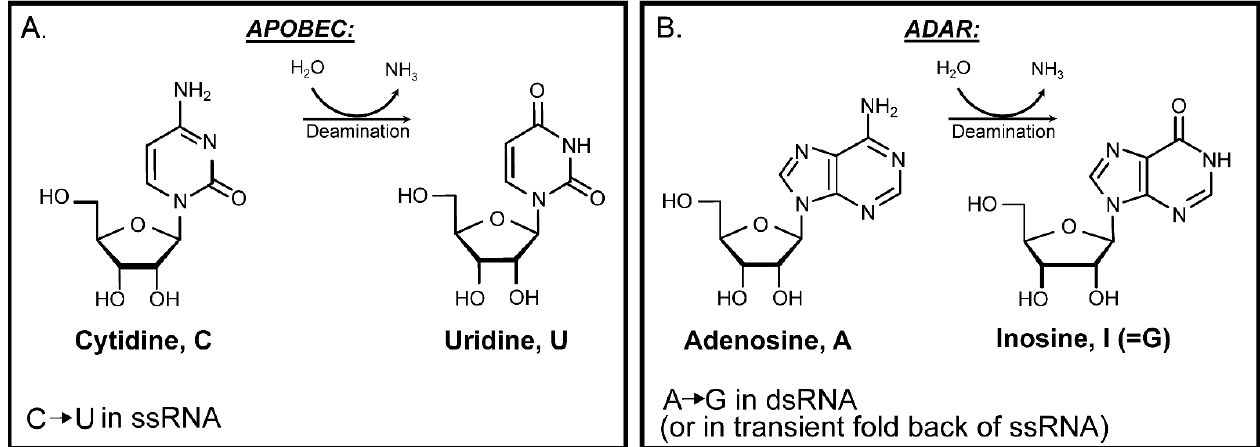
Figure 3. Enzymatic deamination of RNA nucleosides. ( A ) APOBEC cytidine deaminase. Deamination of cytidine in ssRNA generates uridine resulting in C → U mutation in the RNA virus genome. ( B ) ADAR adenosine deaminase. Deamination of adenosine in dsRNA or in folded and paired ssRNA (forming dsRNA) generates inosine, which after rounds of copying with RdRp is fixed as A → G mutation.